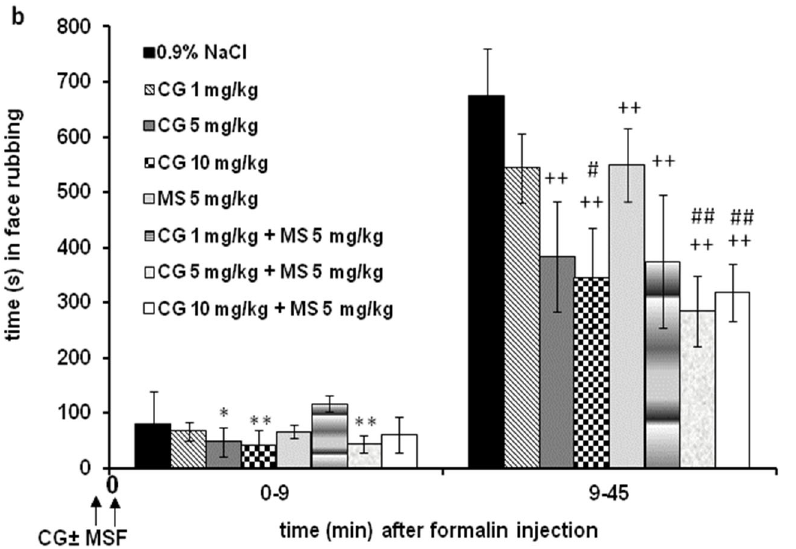
Figure 2. The antinociceptive effect of cromoglycate (CG)–magnesium sulfate (MS 5 mg/kg) combination in the formalin orofacial test in rats. Each bar represents the mean time (in seconds) of face rubbing ± SD observed in 6 rats. Time intervals of nociceptive response (face rubbing) in 3 min intervals are shown in graph ( a ), and the total time spent in the nociceptive response in phase 1 (0–9 min) and phase 2 (9–45 min) in the formalin test is shown in graph ( b ). ( a ) Statistical significance (two-way ANOVA followed by Tukey’s HSD) was determined by comparing with the control (0.9% NaCl; n = 6) (* p < 0.05, ** p < 0.01), + p < 0.05, ++ p < 0.01 in comparison with CG 5 ( n = 6) or 10 ( n = 6), # p < 0.05 in comparison with CG 5 + MS 5 ( n = 6). ( b ) Statistical significance (two-way ANOVA followed by Tukey’s HSD) was determined by comparing with the control (0.9% NaCl; n = 6) ( ++ p < 0.01), * p < 0.05, ** p < 0.01 in comparison with CG 1 + MS 5 ( n = 6), # p < 0.05, ## p < 0.01 in comparison with CG 1 ( n =